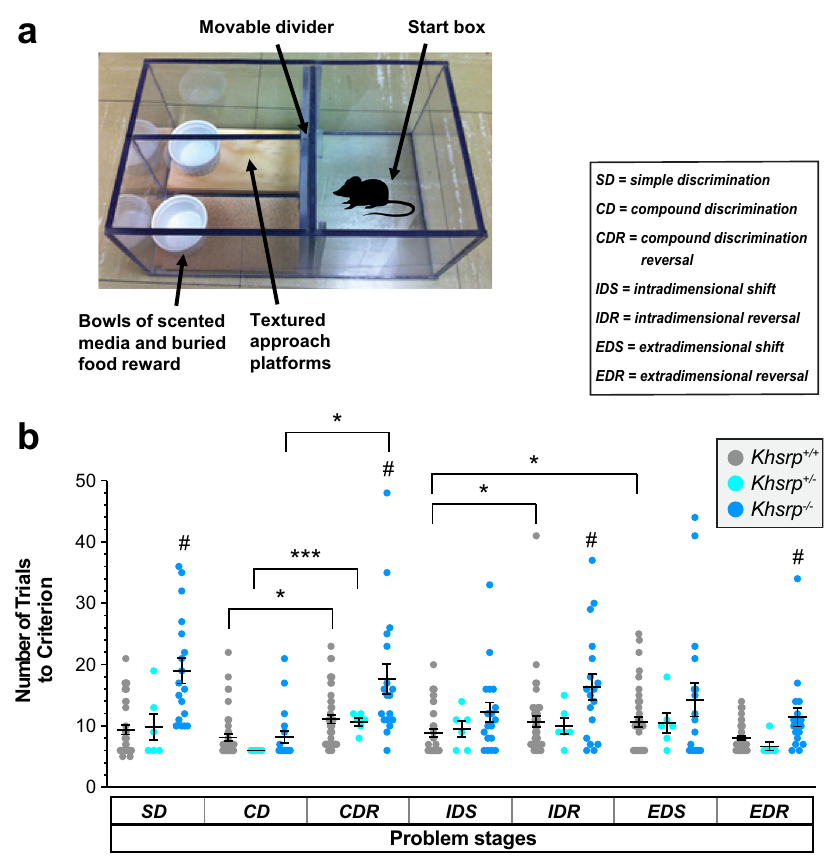
Fig. 7 KHSRP de fi cient mice show decreased prefrontal cortical function in the ASST test. a Diagram of the chamber used for all ASST trials and list of speci fi c problem stages (see Supplementary Fig. 8a for problem stages and stimuli). b All mice were able to perform discrimination (SD, CD, and IDS) and reversals (CDR, IDR, EDR), and showed increased number of trial for CDR vs. CD, although the reversals were no more dif fi cult for Khsrp + / − and Khsrp + / − mice than the preceding stage for IDR vs IDS. Only Khsrp + / + mice formed an attentional set (EDS vs. IDS) while Khsrp + / − and Khsrp + / − did not ( N ≥ 10/ genotype. Data were analyzed by Brown-Forsythe One-way ANOVA tests and Welch ’ s t tests; * p ≤ 0.05, ** p ≤ 0.01, and *** p ≤ 0.001; note error is reported for all values and the column without bars has an error of